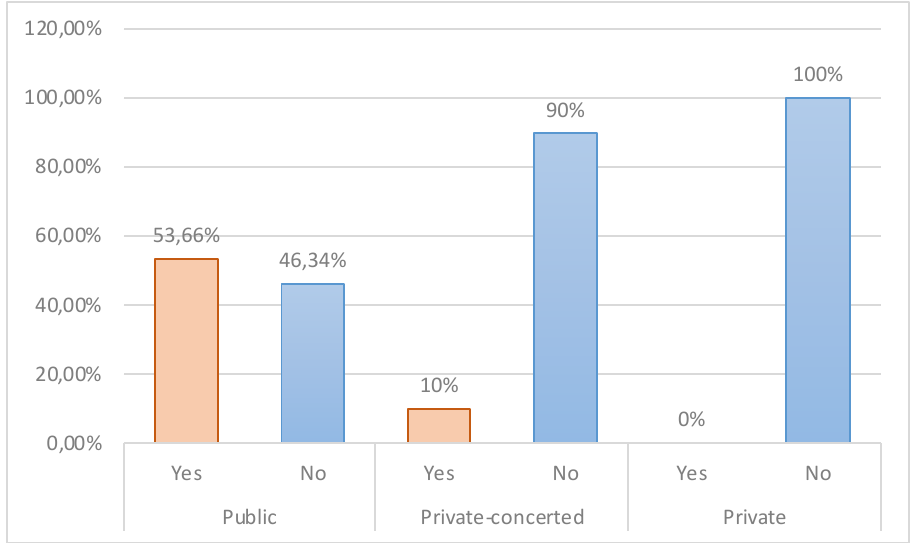
Figure 2. Ownership of the school and concept of SEN.